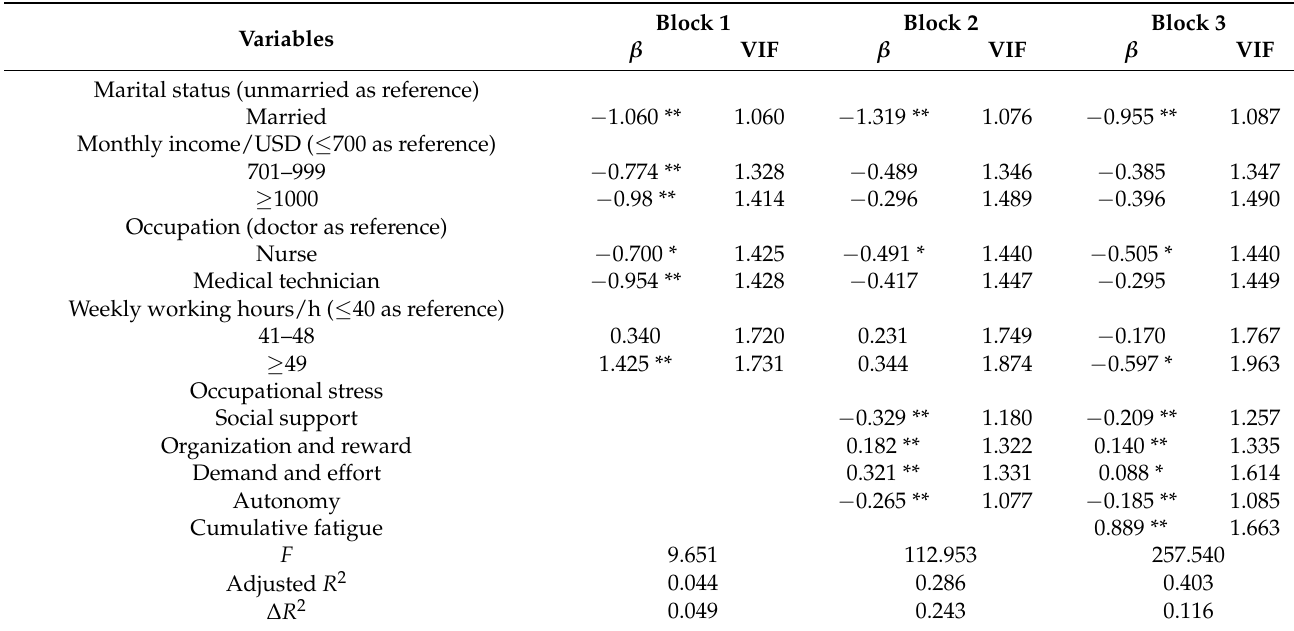
Table 6. Stratified regression analysis on cumulative fatigue, occupational stress, and depressive